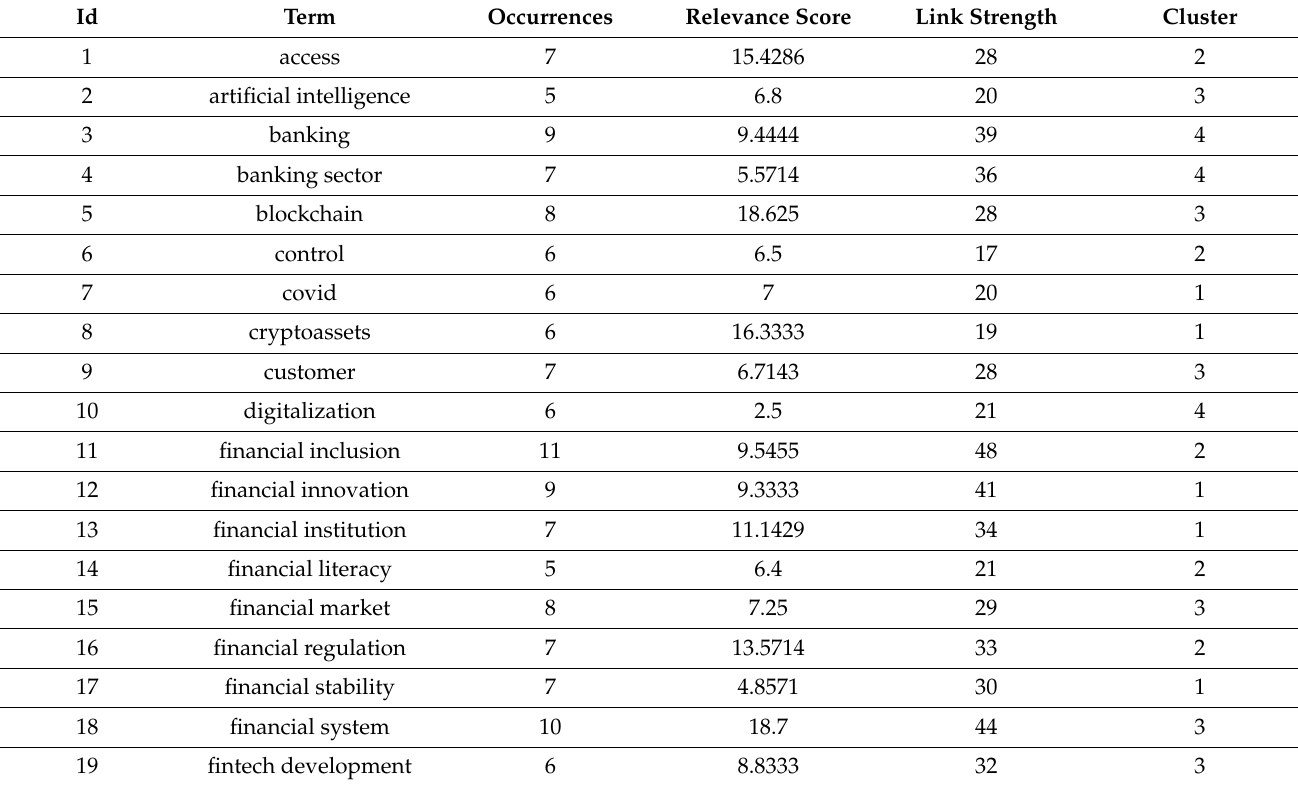
Table 4. Co-occurrence of Terms (‘Authors’